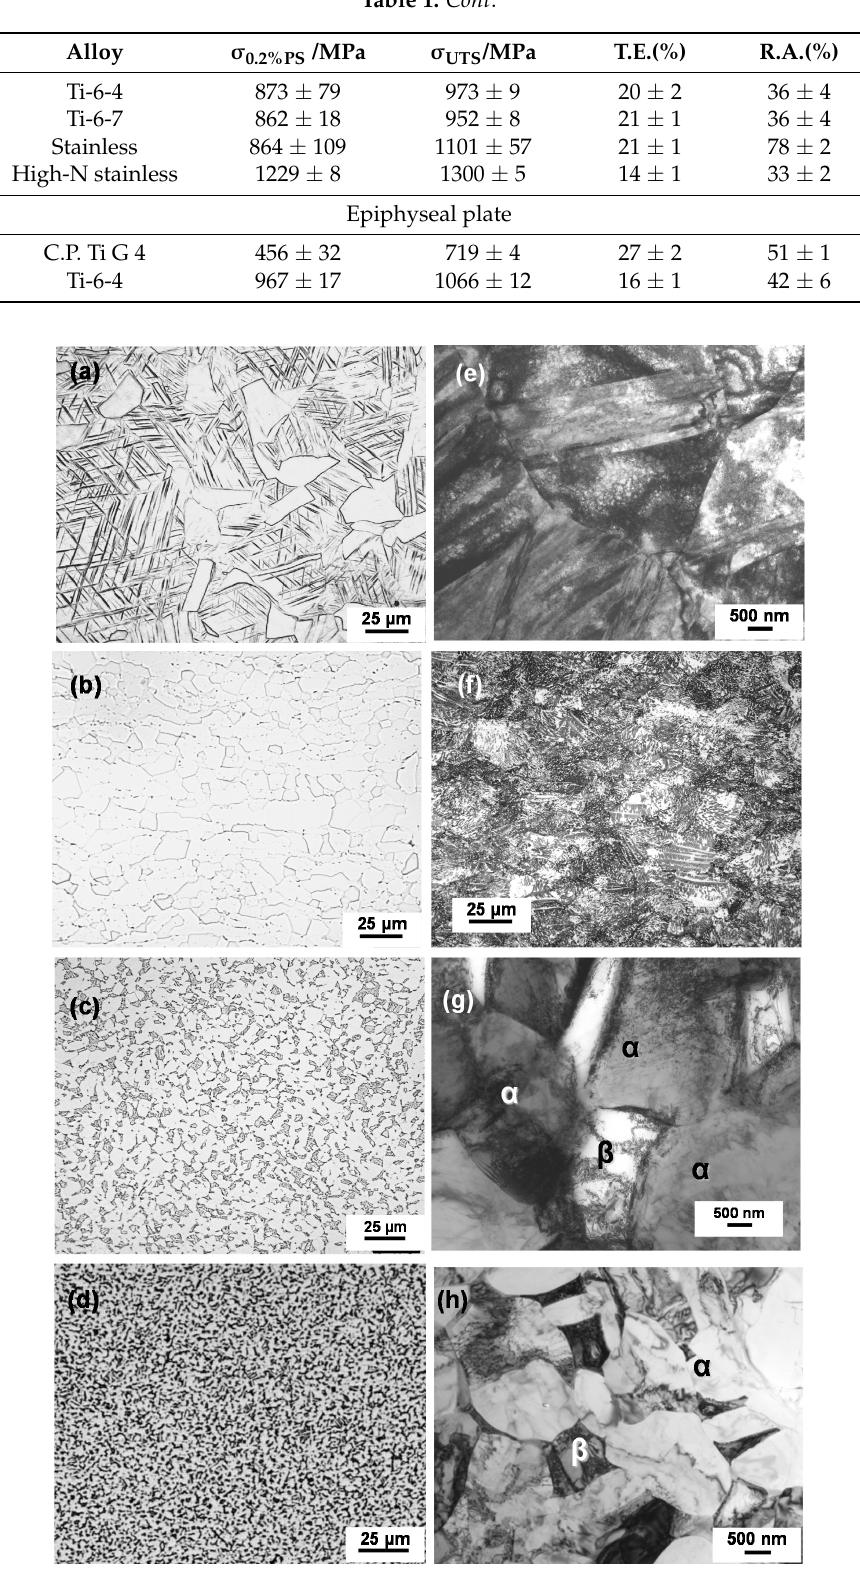
Figure 9. ( a – d ) Optical micrographs and ( e – h ) transmission electron microscopy (TEM) images of ( a , e ) 20% cold-worked stainless, ( b , f ) 20% cold-worked C.P. Ti G 4, ( c , g ) Ti-6Al-4V alloy, and ( d , h ) Ti-15Zr-4Nb-4Ta